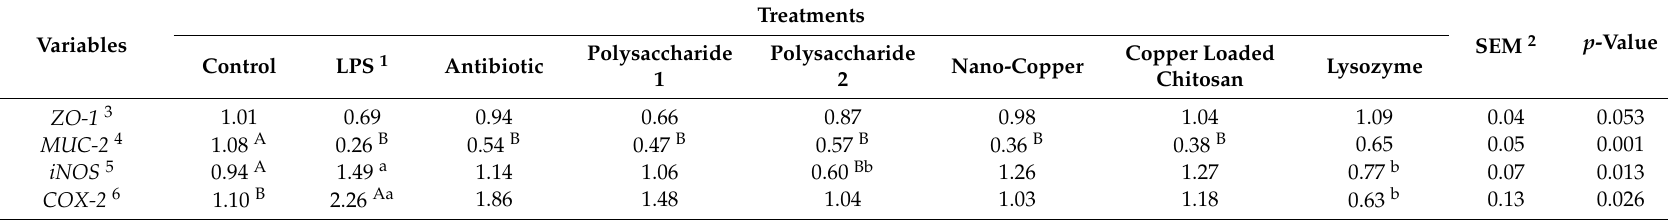
Table 5. E ff ects of mushroom polysaccharide, nano-copper, copper loaded chitosan, and lysozyme on gene expression in jejunal mucosa of yellow-feathered chickens challenged with lipopolysaccharides (LPS).